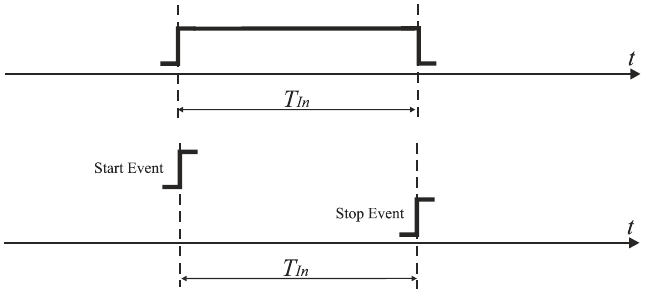
Figure 1. Encoding information in time domain in the form of input time interval T In .